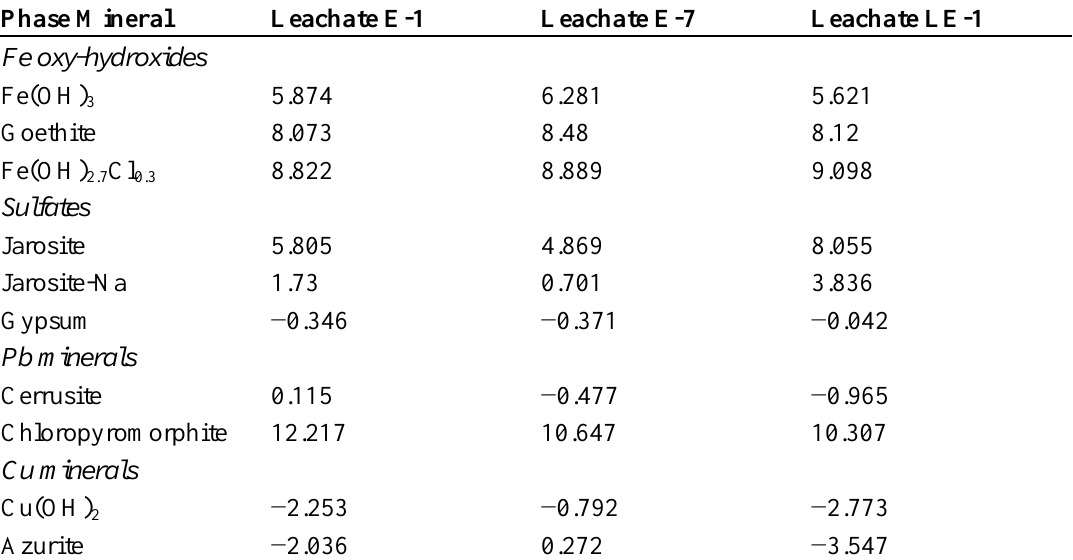
Table 7. Calculated saturation index for selected leachates of pilot-scale experiments. Saturation indices calculated using